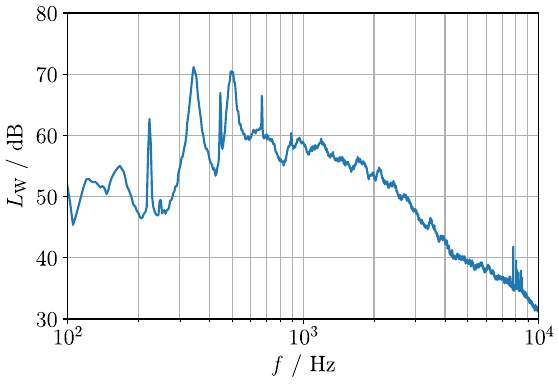
Figure 3. Measured sound power level of the investigated fan.